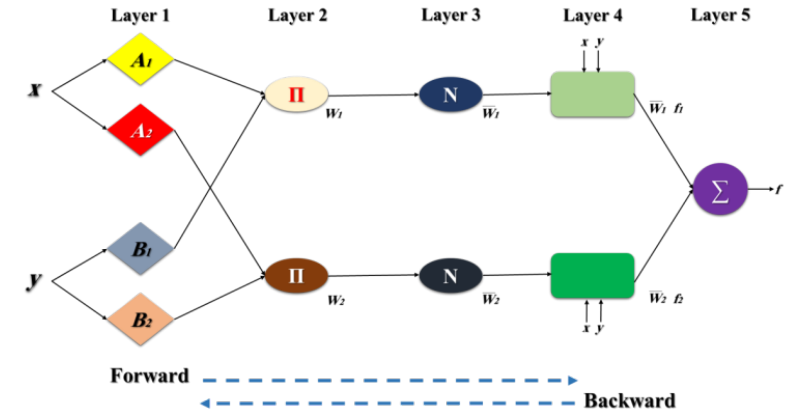
Figure 3. Overview of ANFIS model architecture.